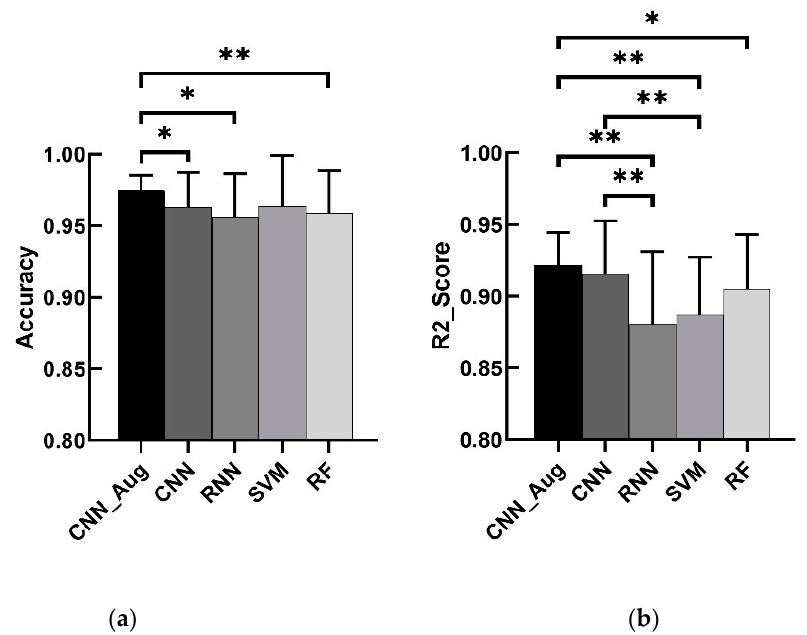
Figure 6. Overall results for di ff erent models: CNN_Aug (presented model) = convolutional neural network with data augmentation, CNN = convolutional neural network without data augmentation, RNN = recurrent neural network, SVM = support vector machine, and RF = random forest. ( a ) The results of hand gesture classification accuracy for di ff erent models. ( b ) The results of finger angle estimation fitting for di ff erent models. ∗∗ denotes p < 0.001 and ∗ denotes p < 0.05.